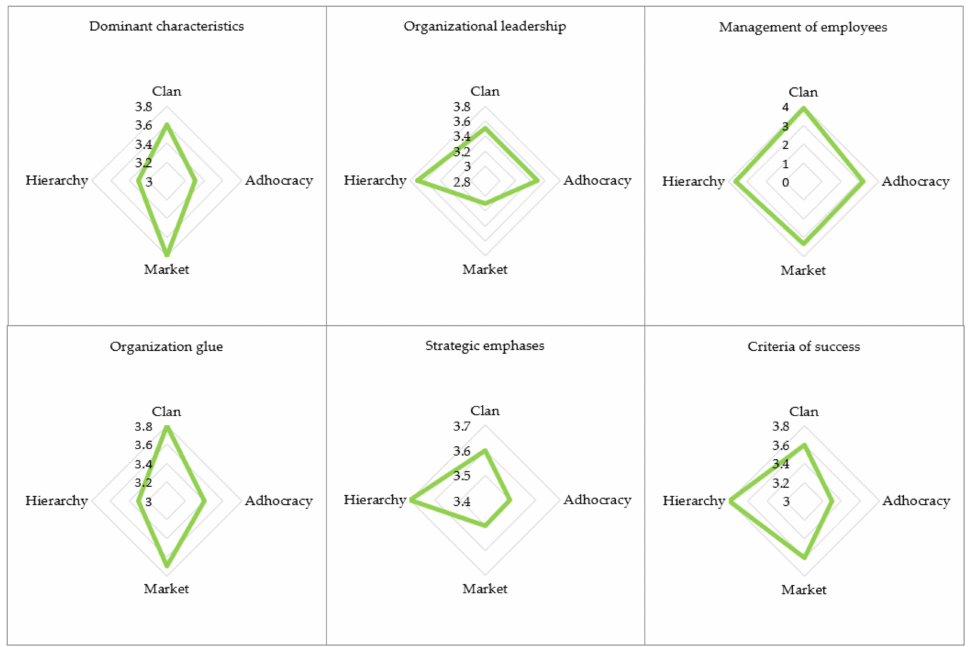
Figure 3. Current status of OC in sample enterprises considering six key dimensions of OC for the overall results.